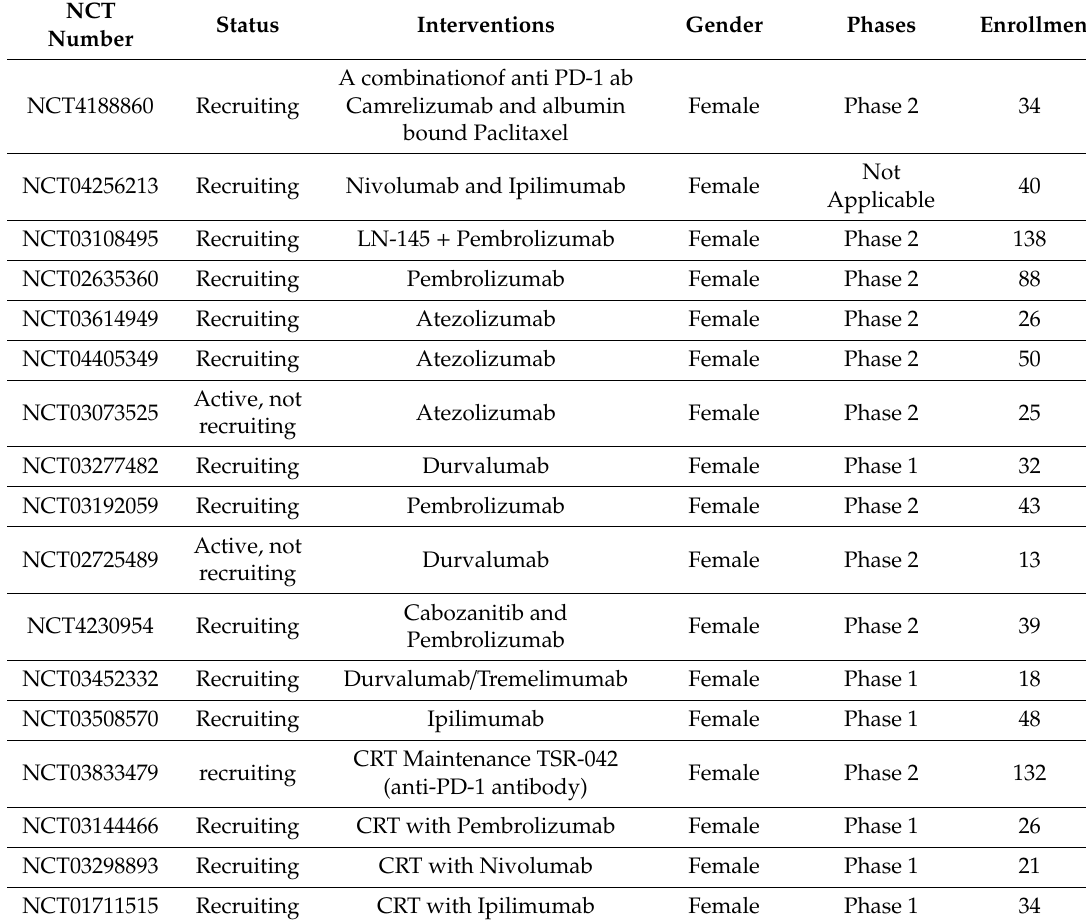
Table 1. Ongoing studies about immunotherapy in cervical